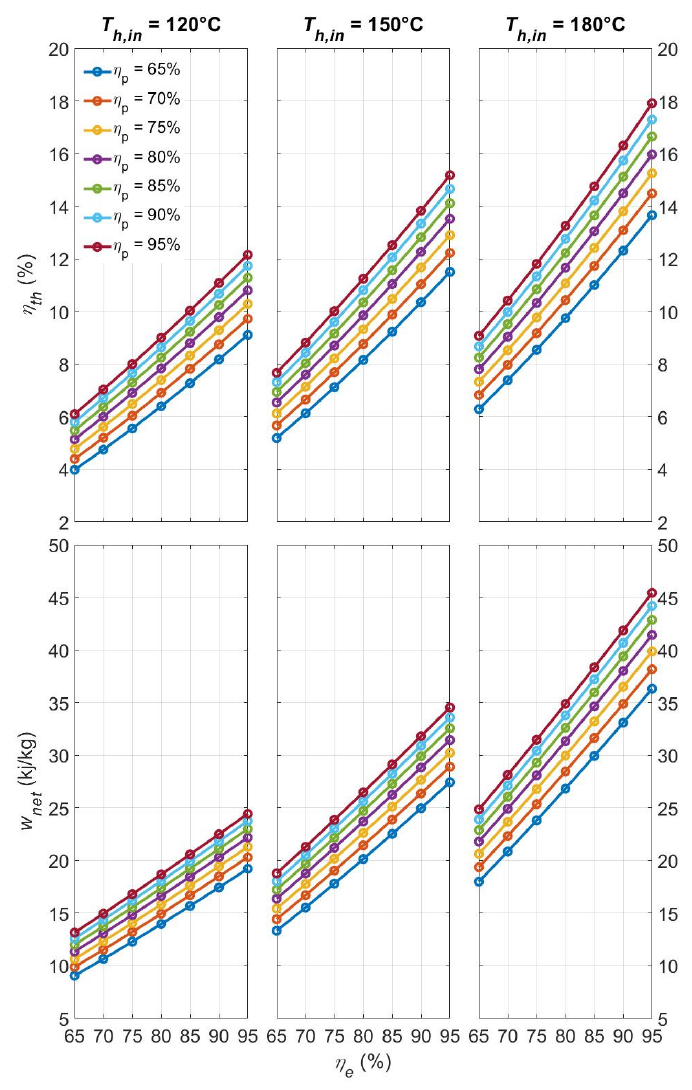
Figure 6. η th and w net of the simple cycle at the design point under different circumstances of η p , η e , Figure 6. 𝜂 (cid:3047)(cid:3035) and 𝑤 (cid:3041)(cid:3032)(cid:3047) of the simple cycle at the design point under different circumstances of 𝜂 (cid:3043) , and T h , in 𝜂 𝑇 (cid:3032) , and (cid:3035),(cid:3036)(cid:3041) .